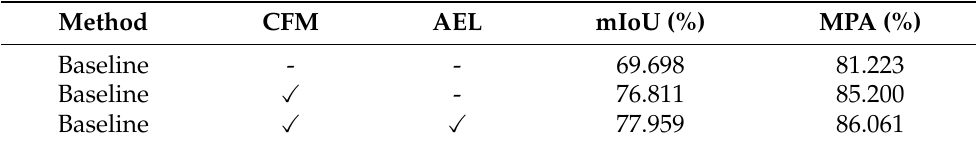
Table 1. Ablation study of FCN likewise models on Potsdam dataset.